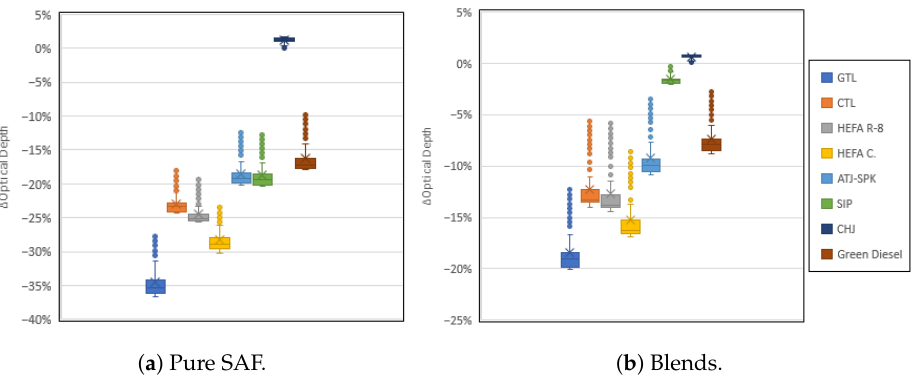
Figure 12. RDs in peak optical depths for ambient relative humidities at formation of 43% or